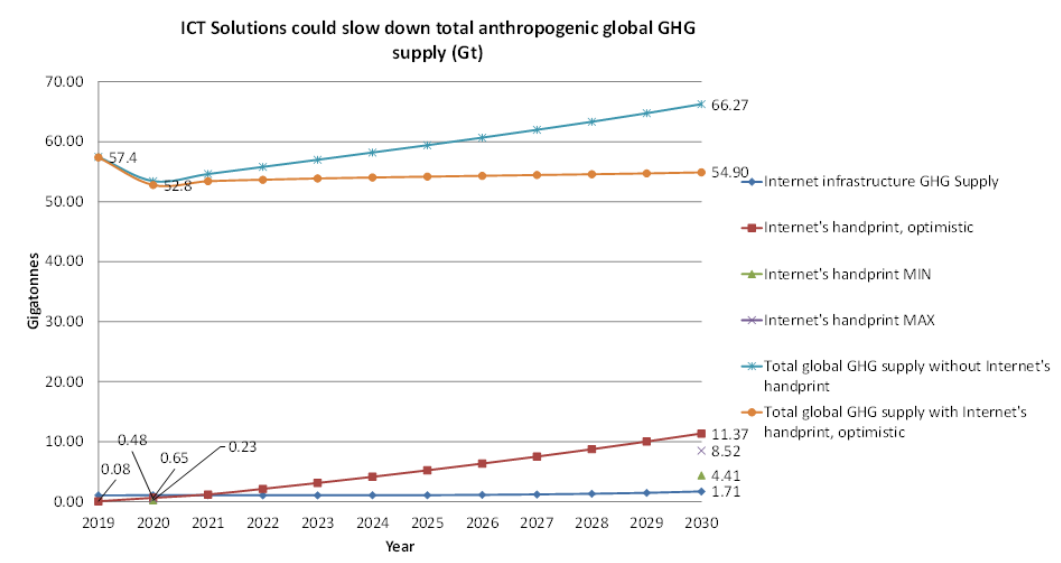
Figure 2. Graphic representation of the effect of ICT Solutions on total anthropogepainic GHG